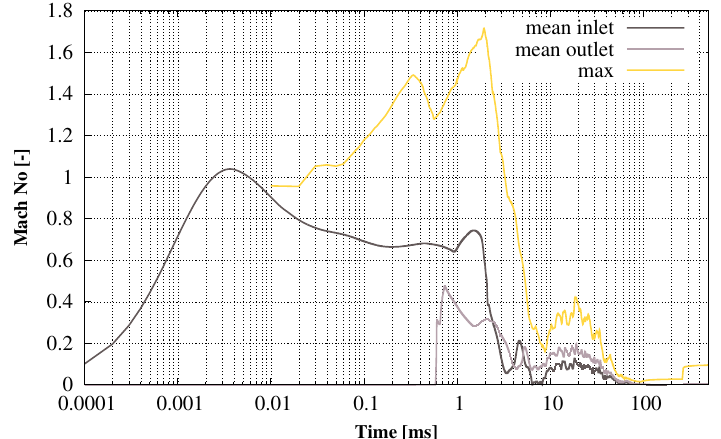
Figure 11. Mean and maximal Mach number at inlet and outlet of the